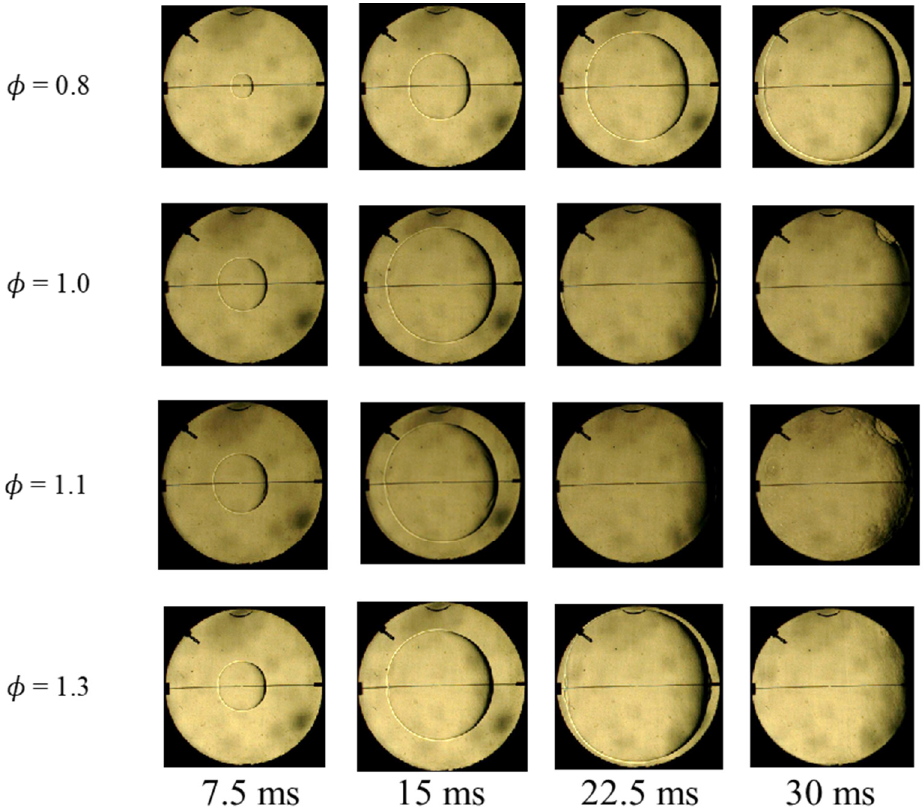
Figure 6. Flame images of ETAC11 (50% ethanol + 50% acetone by volume) at different equivalence ratios, with an initial temperature of 358 K and pressure of 0.1 MPa.